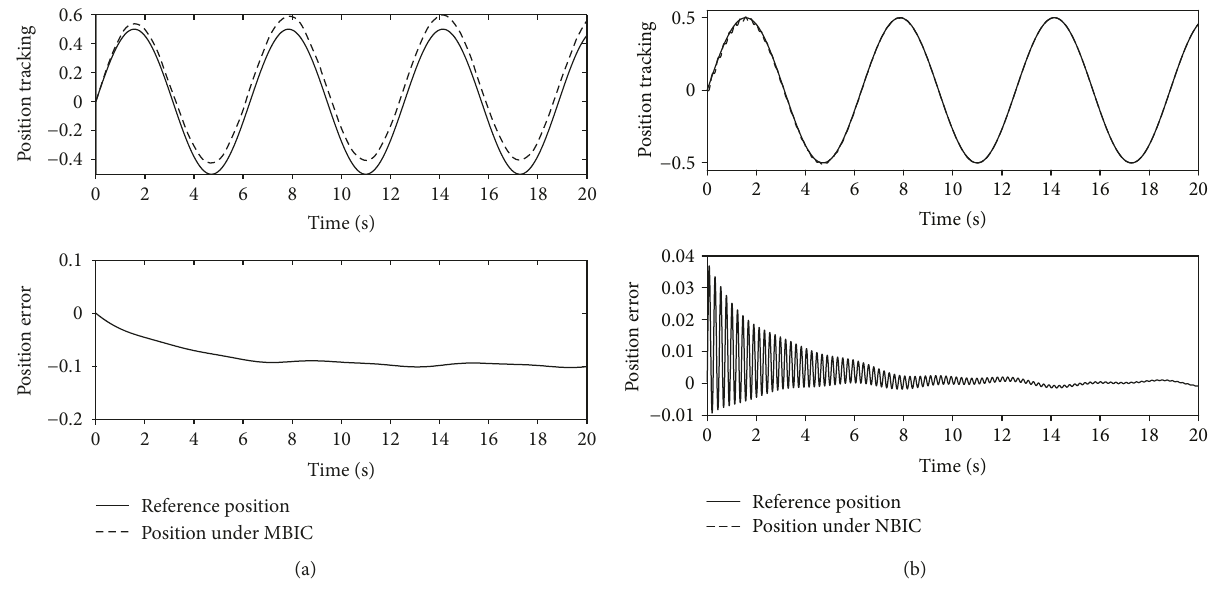
Figure 6: Position tracking and error performance in case II: (a) the MBIC method and (b) the NBIC